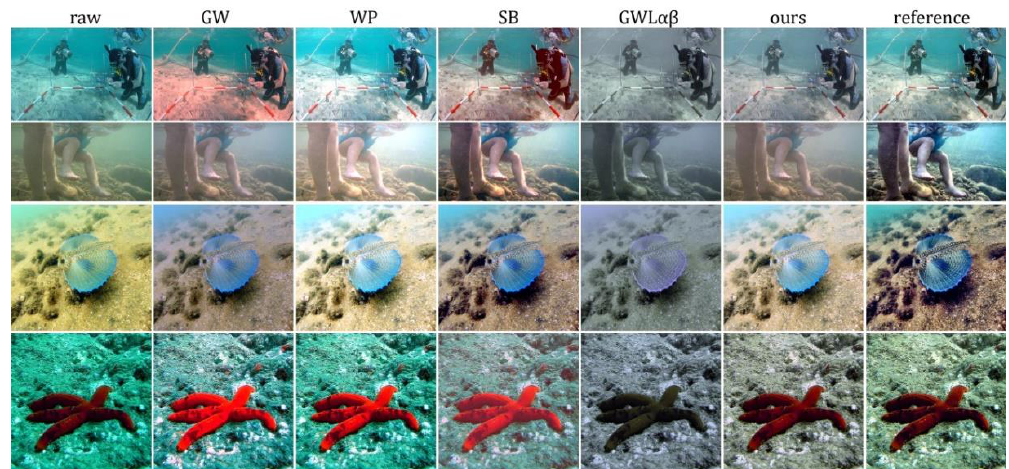
Figure 9. Comparisons on images with color prior. From left to right are raw underwater images, the results of gray-world (GW) method, white-patch (WP) method, statistical-based (SB) method [21], Bianco’s (GWLαβ) method [37], proposed method and reference images.